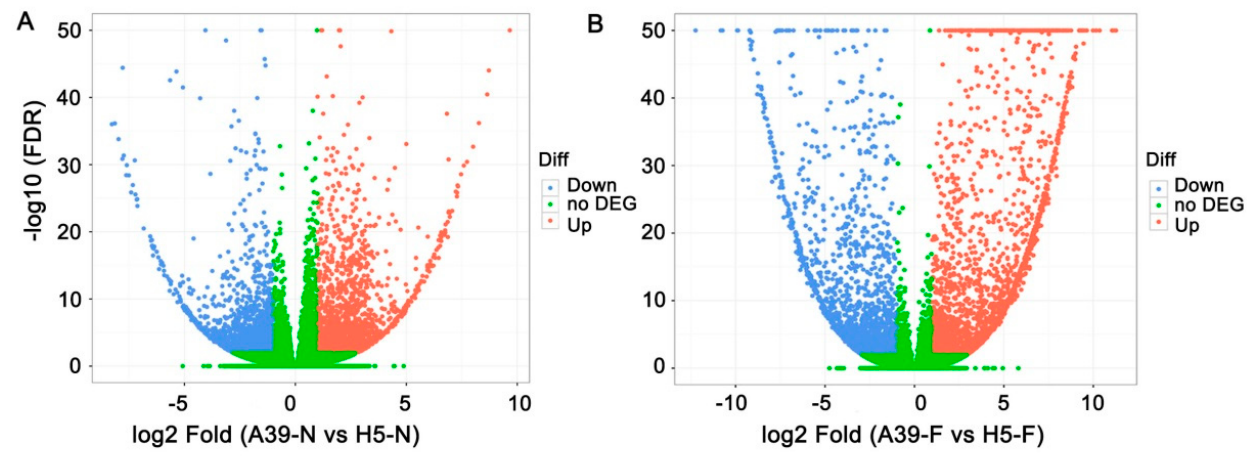
Figure 4. DEGs comparison in leaves of ‘A39’ and ‘H5’ under normal conditions ( A ) and 2 days of FA stress ( B ) Red, green, and blue correspond to up-regulated, unaltered, and down-regulated gene expression, respectively. In addition, to further verify the accuracy of transcriptome data found by RNA-Seq, a total of 17 DEGs (Table S5) were selected and performed using the qRT-PCR method.